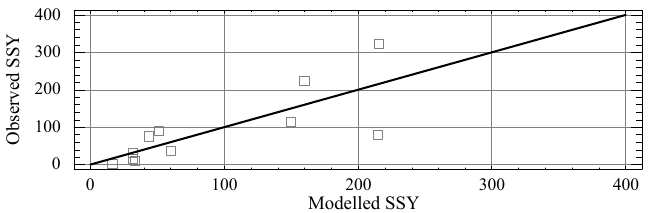
Figure 3. Plot of linear model between observed SSY obs (t/km 2 ) and modeled SSY mod1 SEA/Balance (t/km 2 ) (SSY obs = 13.3072 + 0.55474 * SSY mod1 ).